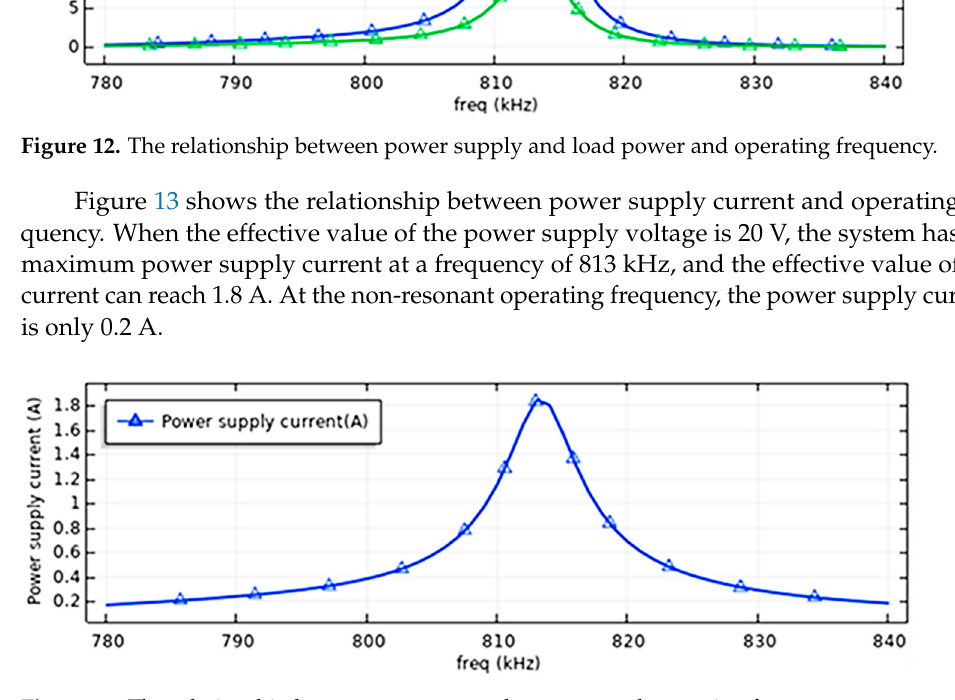
Figure 13. The relationship between power supply current and operating frequency.